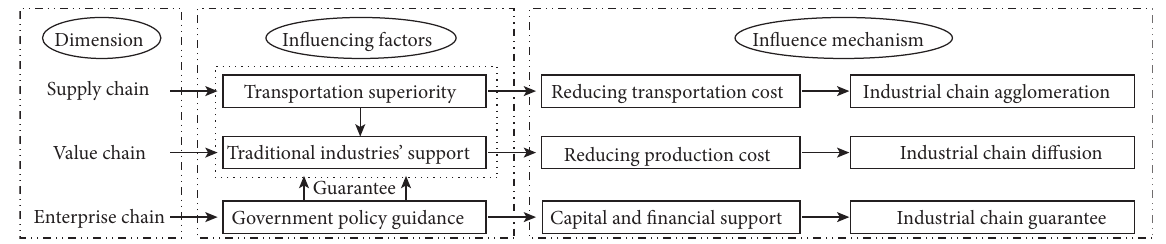
Figure 7: Influence